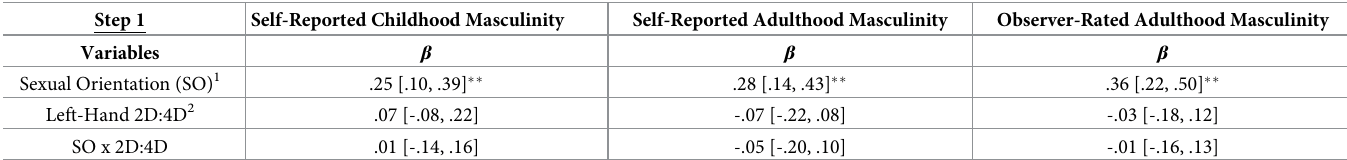
Table 3. Multiple regression analyses for sexual orientation and left-hand 2D:4D predicting self-reported childhood and adulthood masculinity (N = 181) and observer-rated adulthood masculinity (N = 180). Step